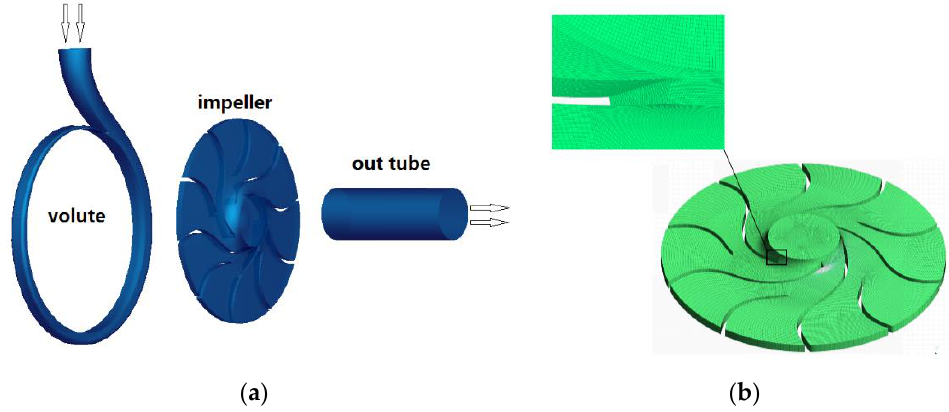
Figure 4. Computational domain and mesh. ( a ) Computational domain; ( b ) mesh.